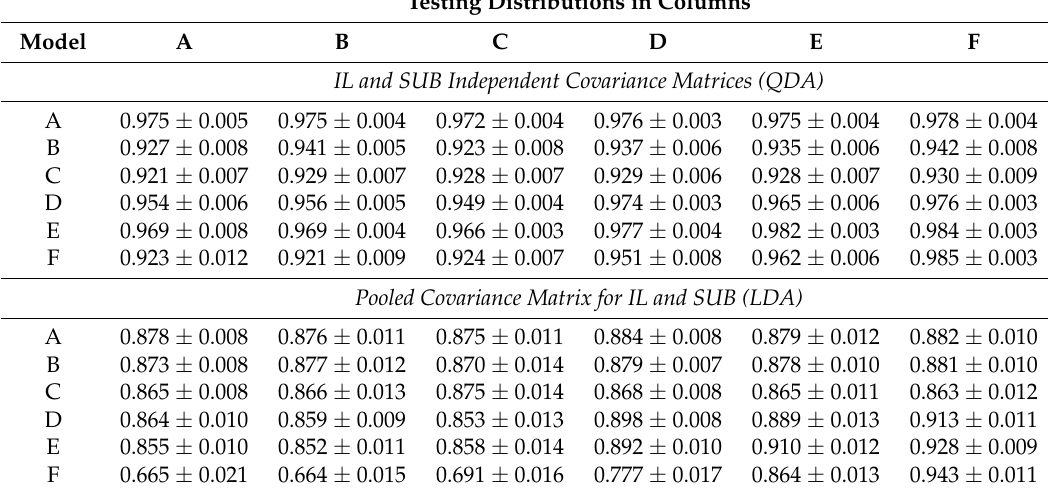
Table 4. Area under the receiver operating characteristic curve (ROC AUC) means and standard deviations from each model distribution (rows, labeled A–F) using each test data set